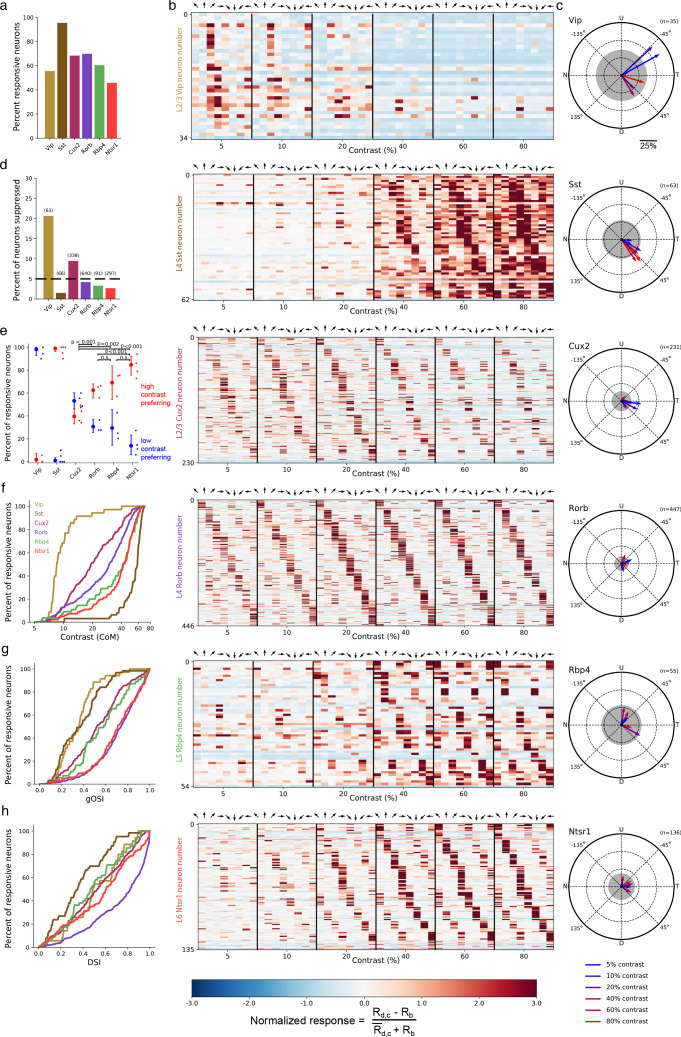
Contrast and direction preferences are cell-type and layer specific.(a) The fraction of imaged cells that were significantly responsive to the gratings stimulus (bootstrapped χ2 test, p<0.01). (b) Waterfall plots showing the response significance at each contrast and direction of all responsive cells (χ2 test; p < 0.01) from mice of each Cre line. Each row is one neuron and neurons are ordered by direction preference at the cell’s peak contrast. The responses to each stimulus condition are normalized per neuron to be RN=(Rd,c−Rb)/(R¯d,c+Rb), where RN is the normalized response, Rd,c is the mean response to a grating with direction d and contrast c, Rb is the mean blank (0% contrast) response, and R¯d,c is the mean response to gratings across all directions and contrasts. (c) Radial plot of the average direction preference of cells of each Cre line at each contrast. Arrows are the vector sum of all responsive cells at a given contrast. Gray shaded region indicates a 95% confidence interval of the vector sum for a population with uniformly-distributed direction preferences, multiple comparisons corrected for the six contrasts. Scale: The distance between each pair of concentric dashed rings is 25%. N: Nasal, T: Temporal, U: Up, D: Down. (d) Fraction of all cells of each Cre line that are suppressed by contrast. The mean response to all grating directions at 80% contrast must be significantly below the mean blank response (bootstrapped distribution of mean response differences; family-wise type 1 error < 0.05; see Materials and methods). (e) Distribution of contrast response types by Cre line determined by fitting of rising sigmoid (high contrast preferring), falling sigmoid (low contrast preferring), or the product of rising and falling sigmoids (intermediate contrast preferring; not shown due to a very small percentage of neurons tuned for intermediate contrasts). P-values are shown for pairwise comparisons of the fraction of high contrast preferring pyramidal neurons in each layer (bootstrap test of difference of sample proportions). See Materials and methods. (f) Cumulative distribution of contrast preferences (center-of-mass of a cell’s contrast response function; CoM) across Cre lines. (g) Cumulative distribution of global orientation selectivity indices (gOSI) across Cre lines. (h) Cumulative distribution of direction selectivity indices across Cre lines.